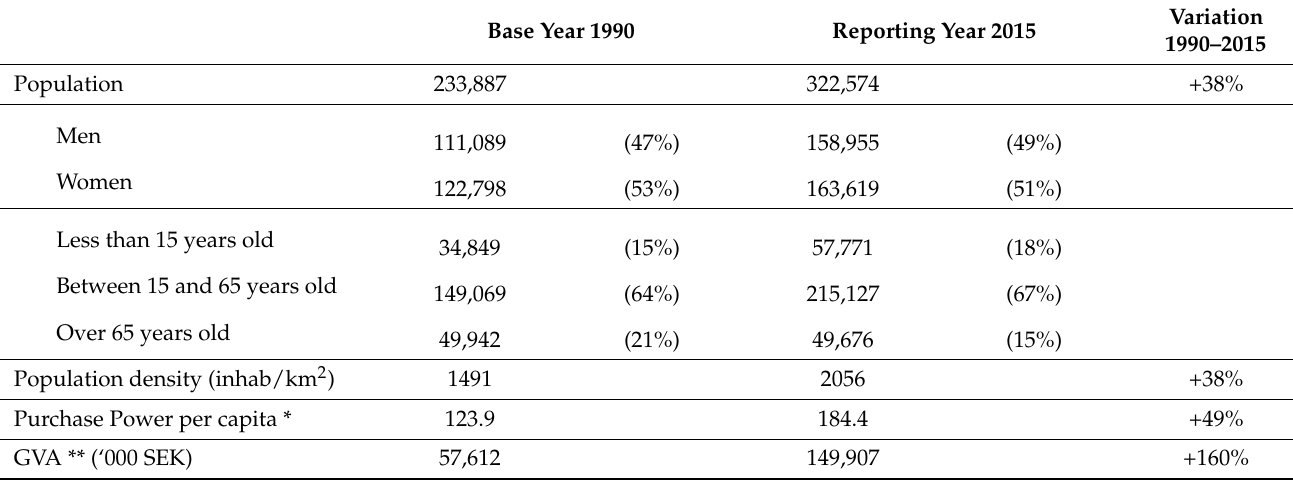
Table 2. Main socioeconomic indicators of the municipality of Malmö for 1990 and 2015 and their variation over